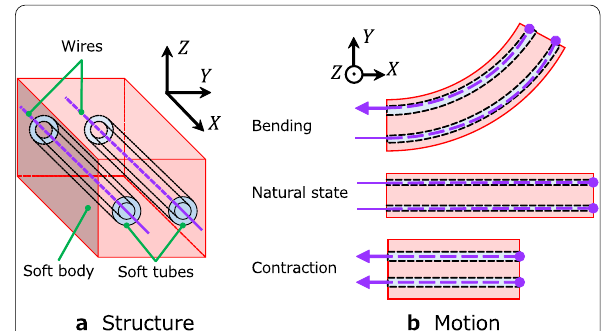
Fig. 1 Schematic diagram of the structure and motion of the planar mechanism with two degrees of freedom. The tension from the combination of two wire enables contraction and bending